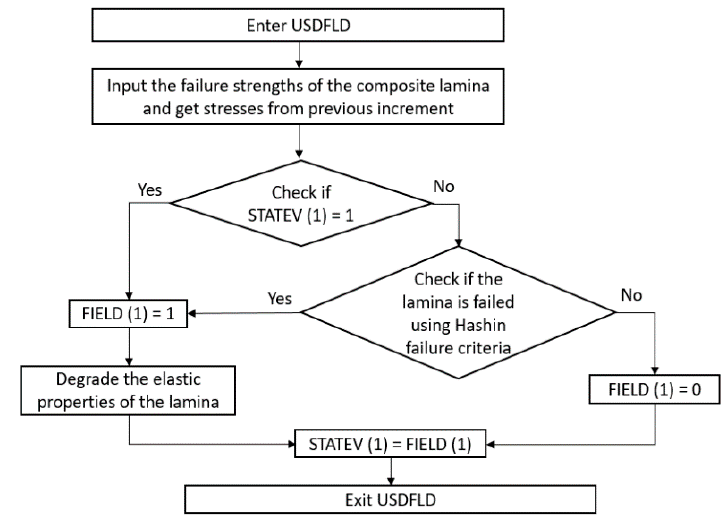
Figure 7. Flowchart of the Progressive Damage Model implemented in the Abaqus user subroutine USDFLD.